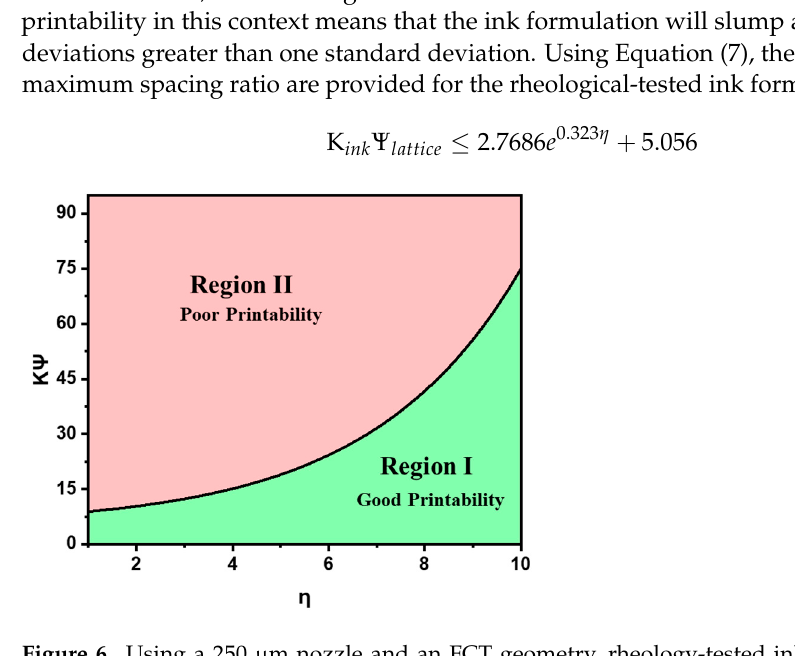
Table 3. Ink parameters for the rheological-tested ink formulations and their maximum spacing ratios according to Equation (7).